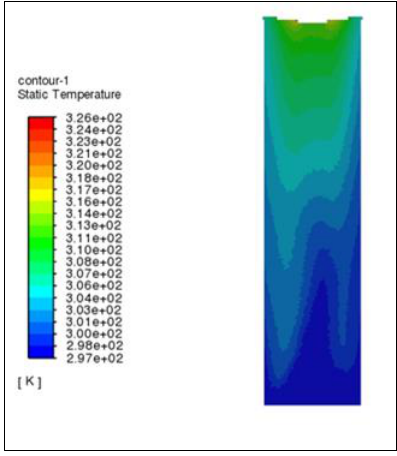
Figure 4. Air temperature nephogram.